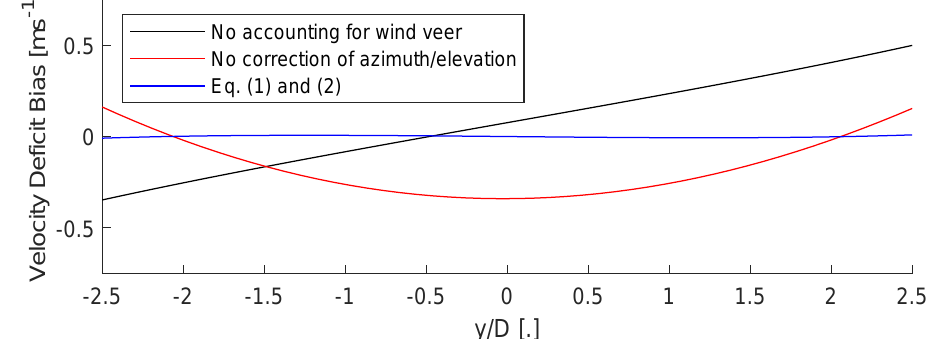
Figure 2. Biases of the velocity deficit resulting from beam geometry and wind veer. The example was computed for z = z hub − 40 m with an assumed inflow with a wind speed of 5 m s − 1 and a wind veer of 0.25 ◦ m − 1 . Neglecting a correction of the azimuth and elevation angles (red line—i.e., applying only Equation (1)) and neglecting the effect of wind veer (black line—i.e., applying Equation (2) on the radial velocities) will introduce a bias compared to Equation (2) (blue line). The effect of wind shear would manifest as a constant